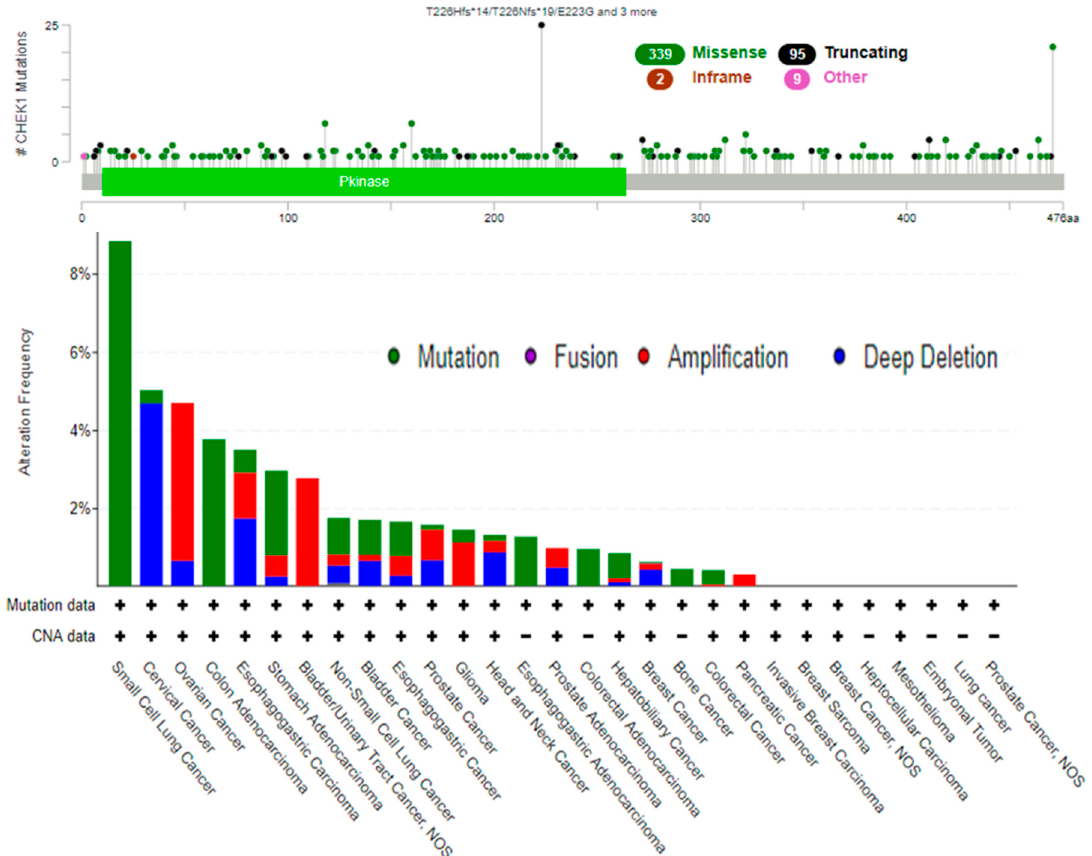
Figure 7. Mutation hotspot of CHEK1 across cancer studies. A total of 445 mutation sites were detected and located between amino acids 0 and 300. CHEK3 mutation mainly occurred in lung cancer and existed in a hotspot in the Pkinase domain.